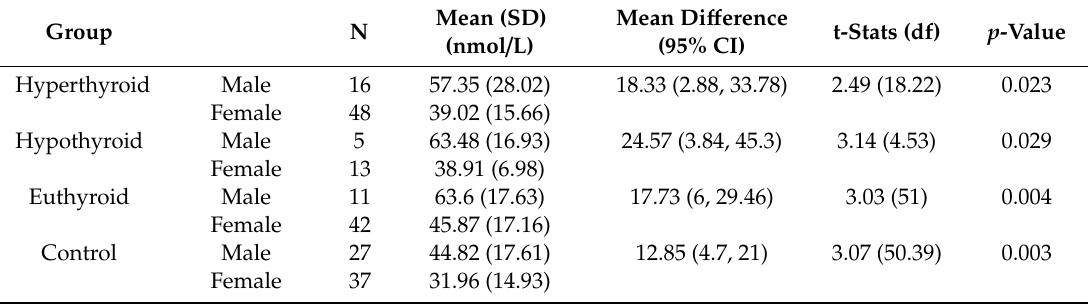
Table 3. Serum 25(OH)D Level In Between Groups, Comparing Male and